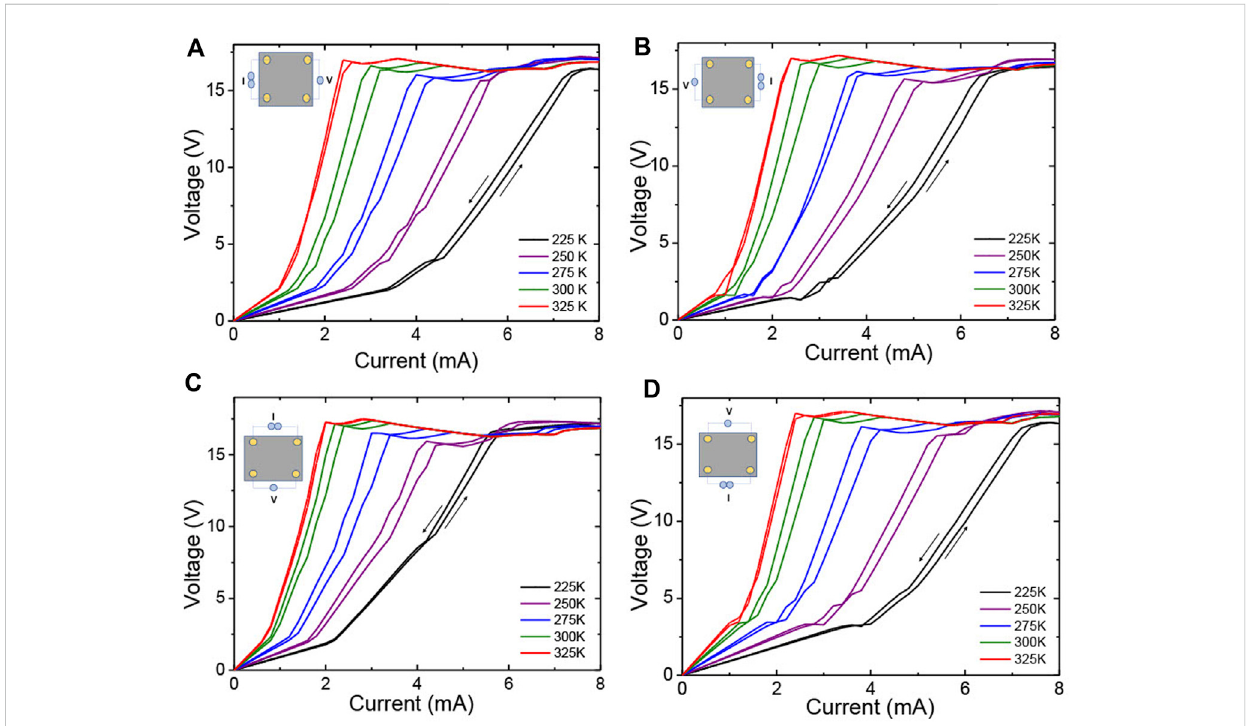
FIGURE 3 Current-controlledhystereticresistiveswitchingbehavioratdifferenttemperaturesshownfrom225 Kto325 Kfor (A) left-vertical, (B) right-vertical, (C) top-horizontal, and (D) bottom-horizontal directions. Left (right)-vertical refers to current sourcing in the vertical direction through a pair of left or rightcontacts.Currentsourcinginthehorizontaldirectionusingapairoftoporbottomcontactsisreferredtoastop-horizontalorbottom-horizontal.As the temperature increases and approaches T MIT , the current needed for switching to occur decreases establishing the Joule heating origin of the